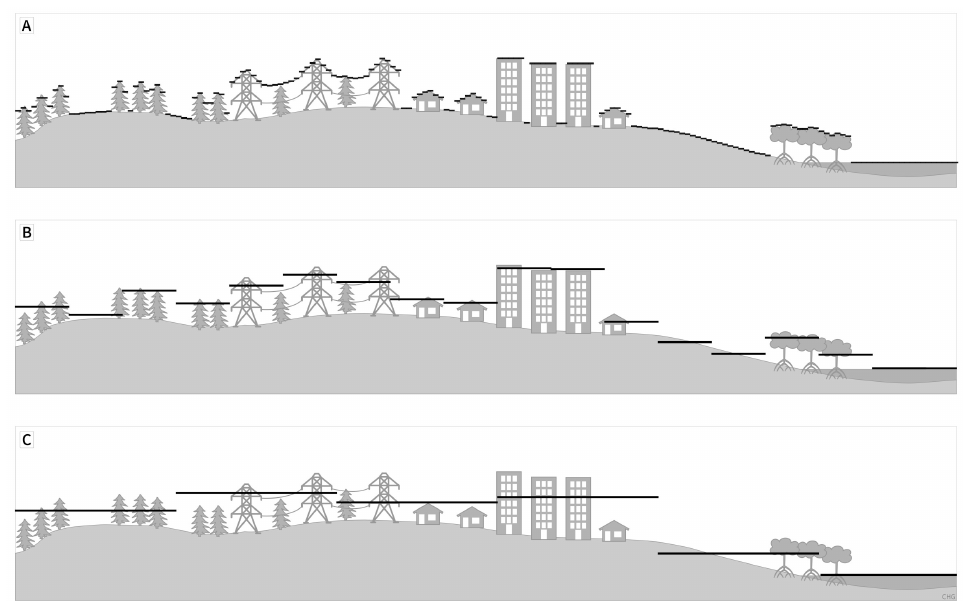
Figure 7. Stepwise nature of DEM grids with increasing grid spacing (schematic representation). These might be ( A ) 1–2 m grid spacing from lidar, ( B ) 30 m (1 arc second) or ( C ) 90 m (3 arc second), where one elevation (a) represents the entire cell and (b) depends on the measurement